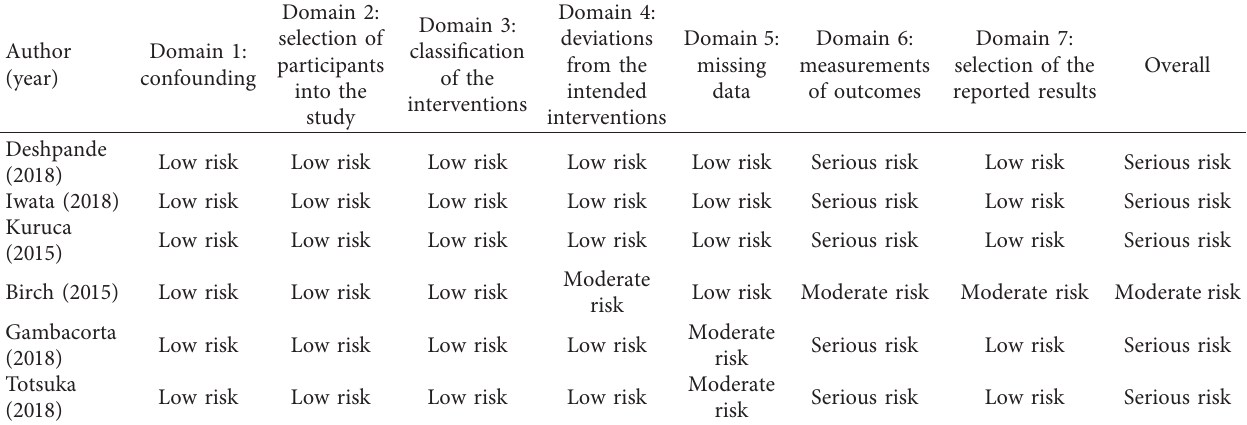
Table 4: Results of ROBINS-I tool for risk of bias assessment.